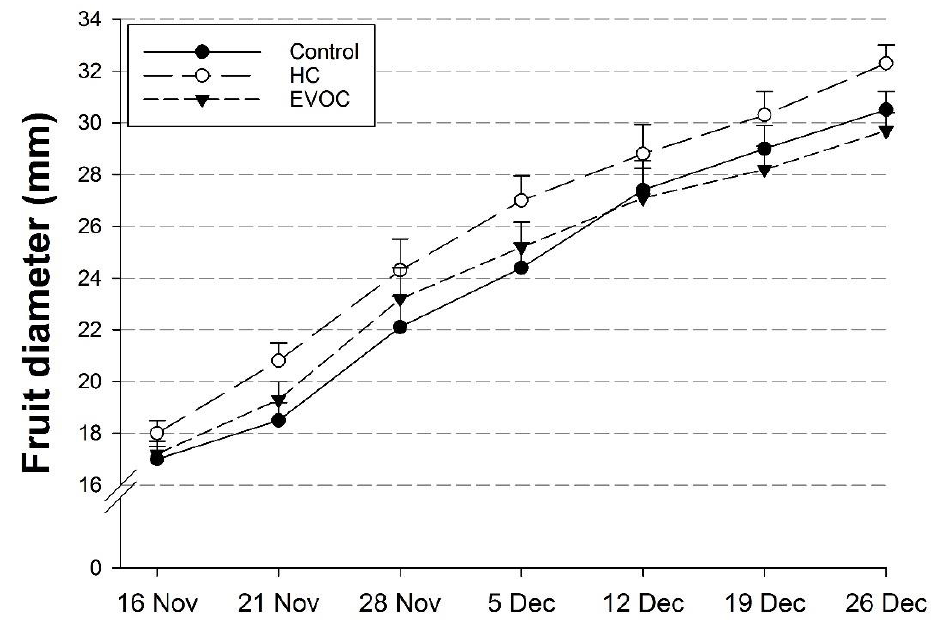
Figure 7. Increase in fruit diameter of the sweet cherry cultivar ‘Lapins’ from straw stage to commercial harvest. Error bars are the least significant differences ( p < 0.05).